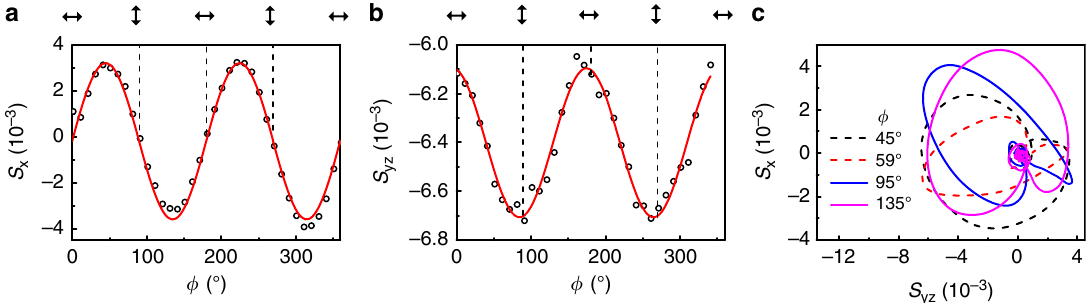
Fig. 5 The obtained THz EO signals by rotating the half-wave plate. a and b display S x ( t = 0.03 ps) and S yz ( t = − 0.02 ps) (near the peak values) as a function of the linear polarization angle, ϕ , respectively. The red solid lines show the fi tted results. c shows the polarization trajectory ( S yz ( t ), S x ( t )) for different linearly polarized pump light with several typical ϕ . The solid and dashed curves represent opposite chiralities.